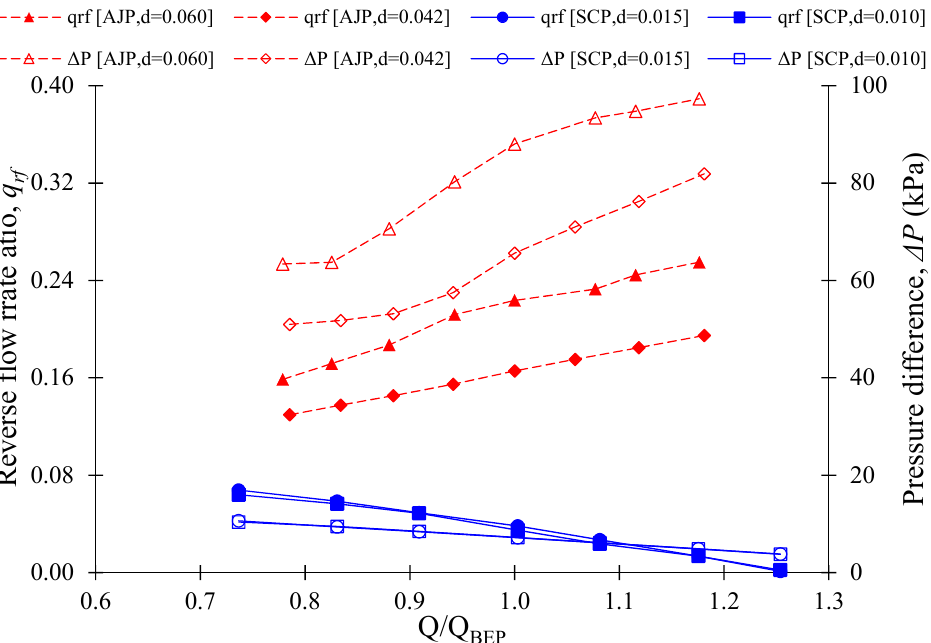
Figure 16. Reverse flow rate ratio and pressure difference variation in the J-Groove channel of AJP and SCP models.